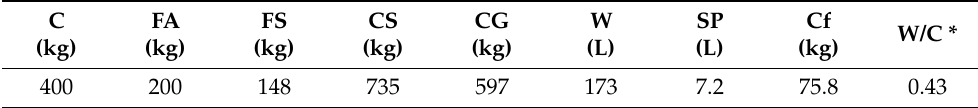
Table 1. Mix proportions for 1 m 3 of recycled steel fiber reinforced concrete